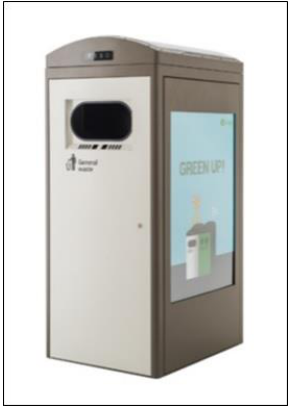
Figure 9. An experimental product by E-cube Lab.